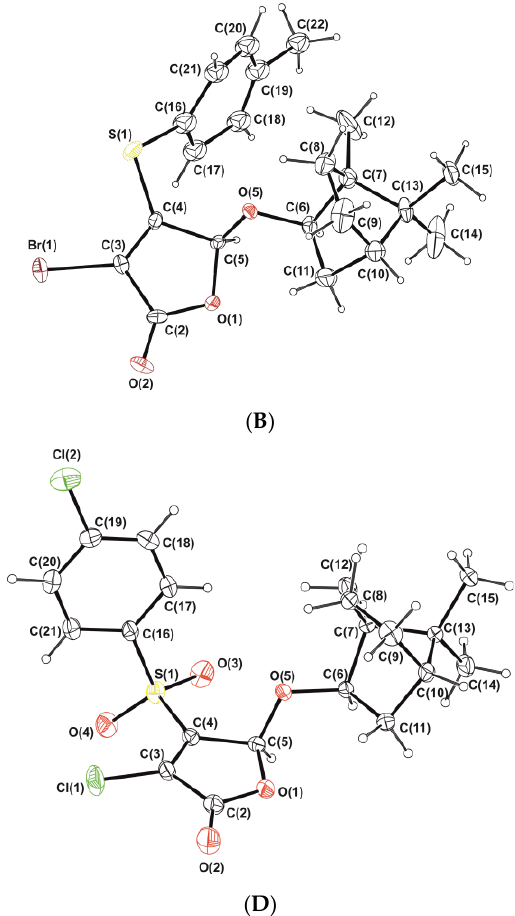
Table 1. In vitro antimicrobial activity of 2(5 H )-furanone derivatives 7 – 30 and reference drugs (MICs, μg/mL). The median values from five independent experiments are shown. Gram-Positive Compounds